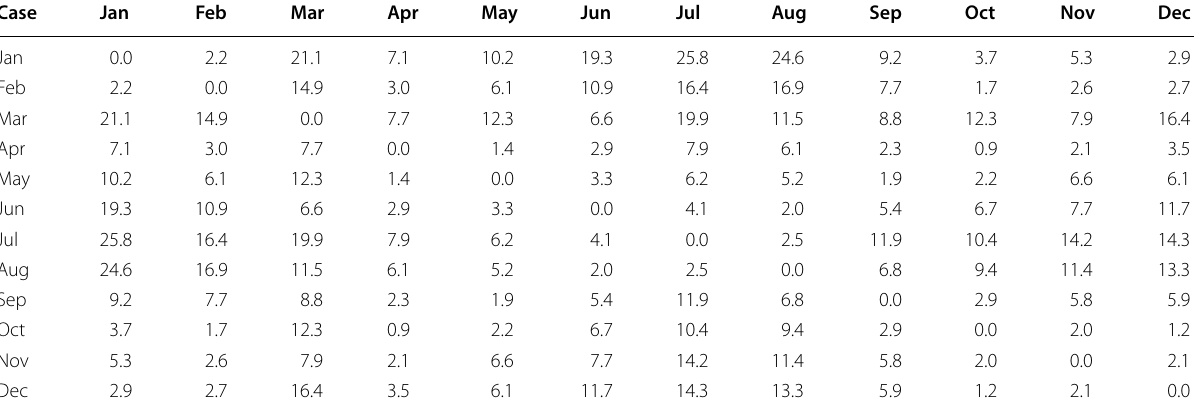
Table 8 Proximity matrix between 12 months (cases) based on squared Euclidean distance in HCA Case